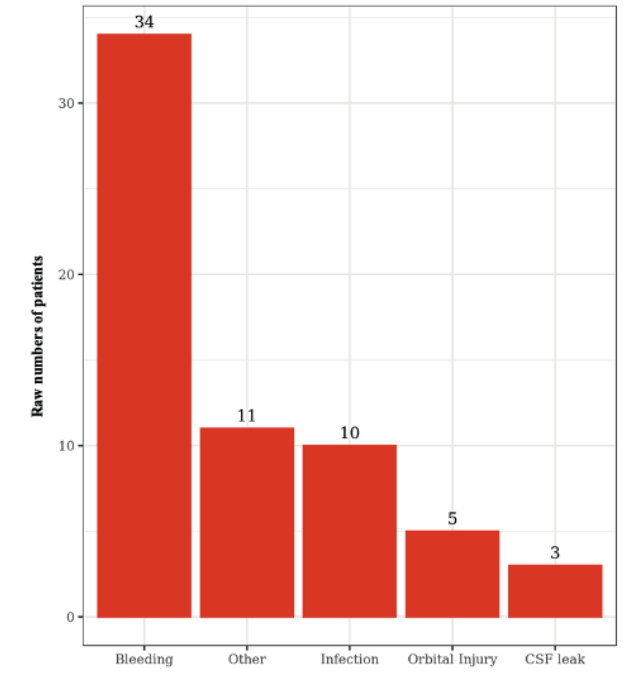
Figure 4. Complications by